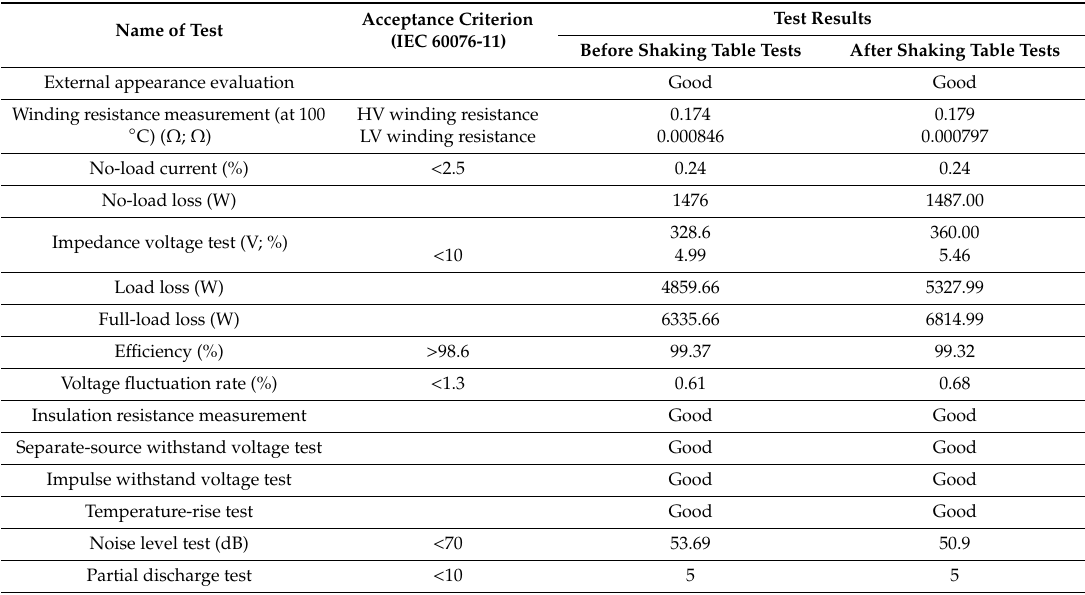
Table 5. Operational test